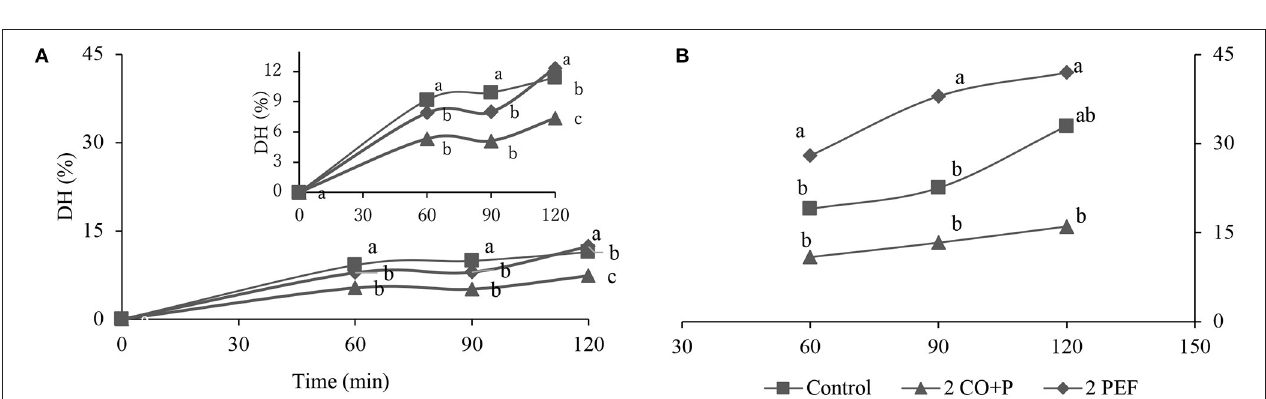
FIGURE 4 | Degree of hydrolysis (DH) of the digested samples, (A) the gastric phase at 0, 60, 90, and 120min and (B) the duodenal phase at 60, 90, and 120min. Lowercase letters indicate statistically significant ( p < 0.05) differences.